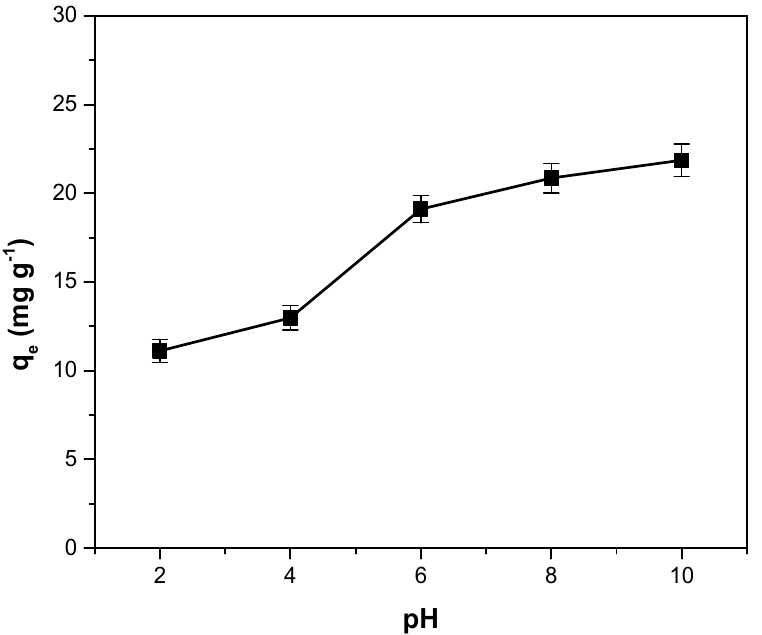
Figure 7. The influence of the pH solution on adsorption capacity for crystal violet adsorption on adsorbents obtained from motherwort biomass.